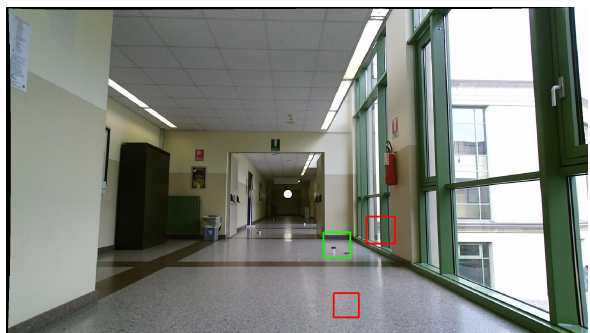
Figure 2. Example of Pozyx UWB anchor recognition: correctly classified anchor (green box), examples of candidates not classified as anchors (red